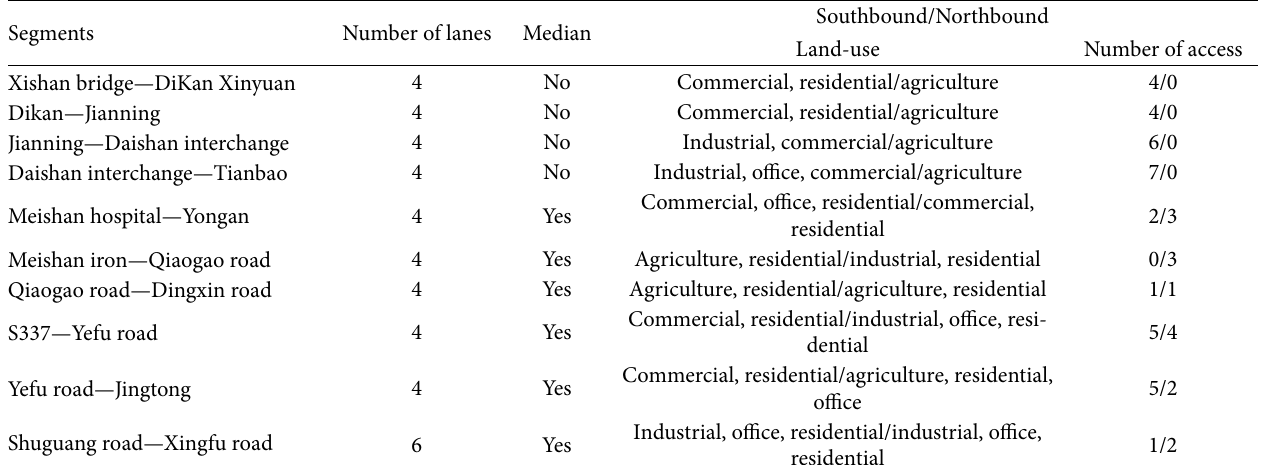
Table 2: Segments